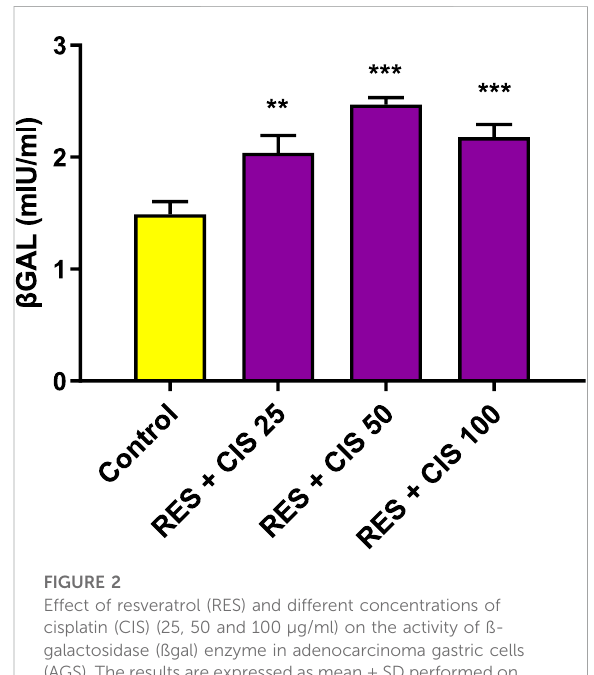
FIGURE 2 Effect of resveratrol (RES) and different concentrations of cisplatin (CIS) (25, 50 and 100 μ g/ml) on the activity of ß- galactosidase (ßgal) enzyme in adenocarcinoma gastric cells (AGS). The results are expressed as mean ± SD performed on n = 6, with two independent replicates. *** ( p < 0.001) and ** ( p < 0.01)show asigni fi cant differencecomparedto thecontrol